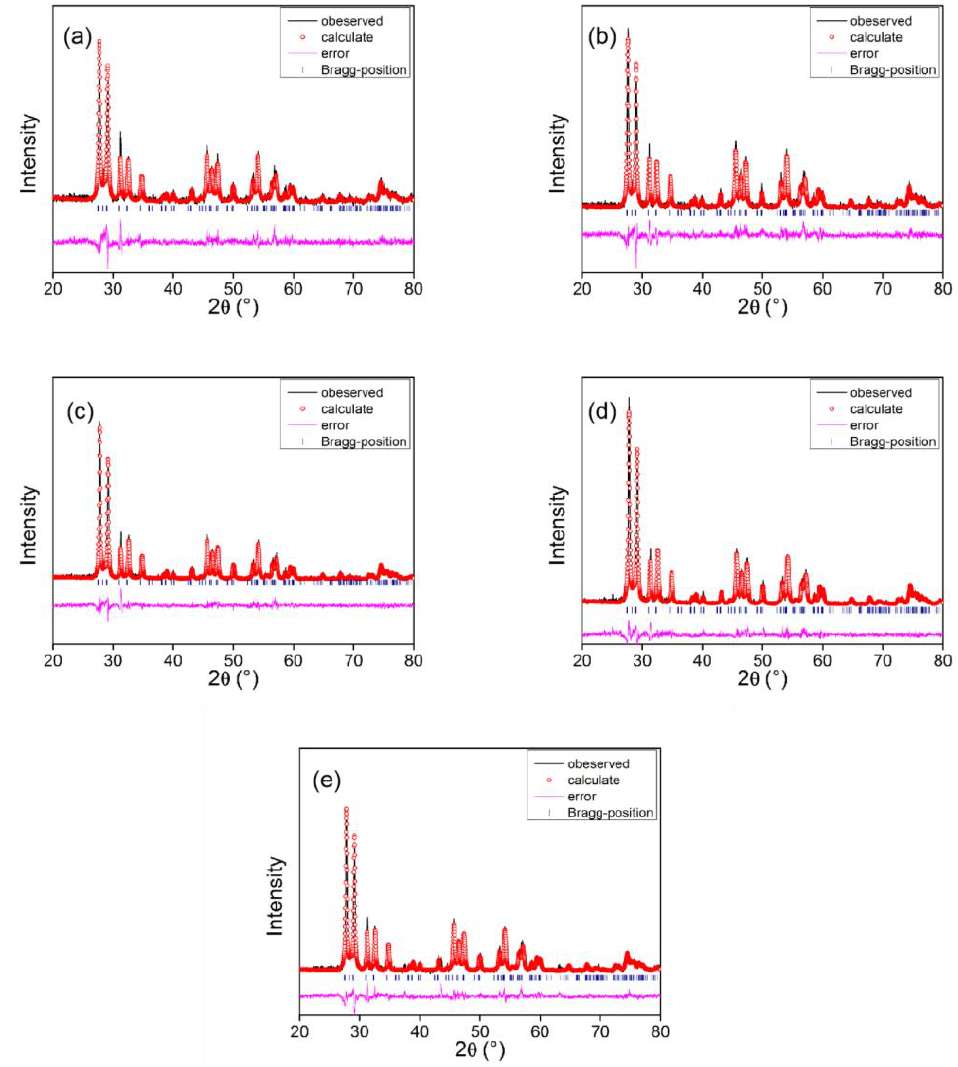
Figure 8. Rietveld refined XRD patterns of ( a ) undoped LCNO, ( b ) 1% externally doped LCNO, ( c ) 1% internally doped LCNO, ( d ) 2% internally doped LCNO and ( e ) 5% internally doped LCNO.